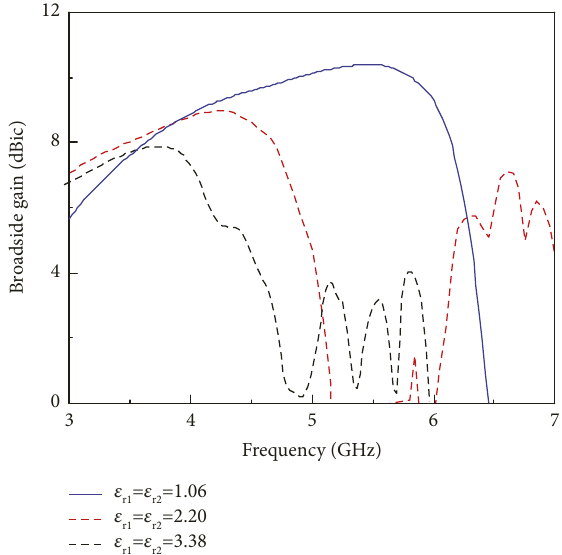
Figure 6: Effects of the substrate dielectric constant on the broadside gain of the antenna. Table 2: Performance summary of the antenna with different dielectric constants for both the lower and upper substrates. Lower substrate dielectric constant, ε